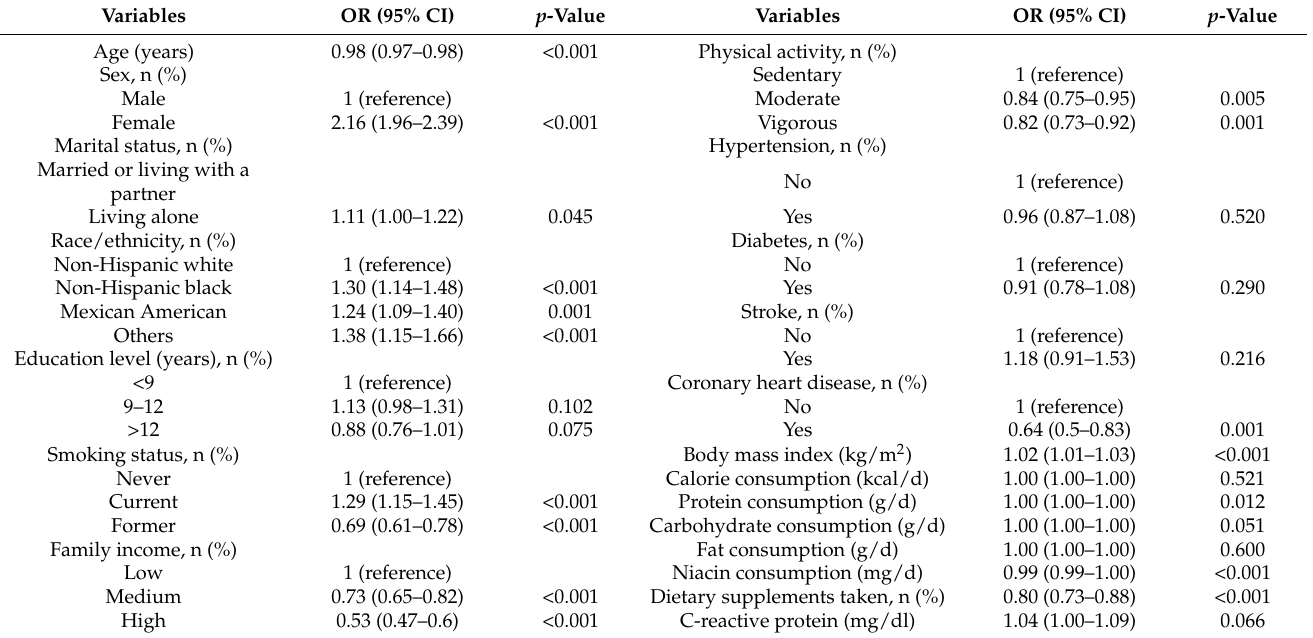
Table 2. Association of covariates and migraine risk.